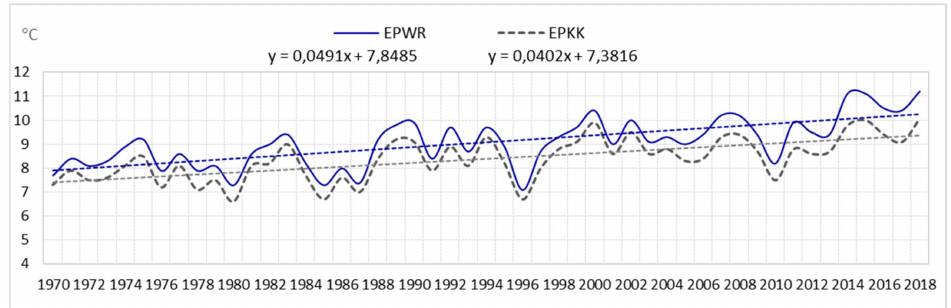
Figure 10. Average annual air temperature and linear trend in EPPO and EPWA (1970–2018).